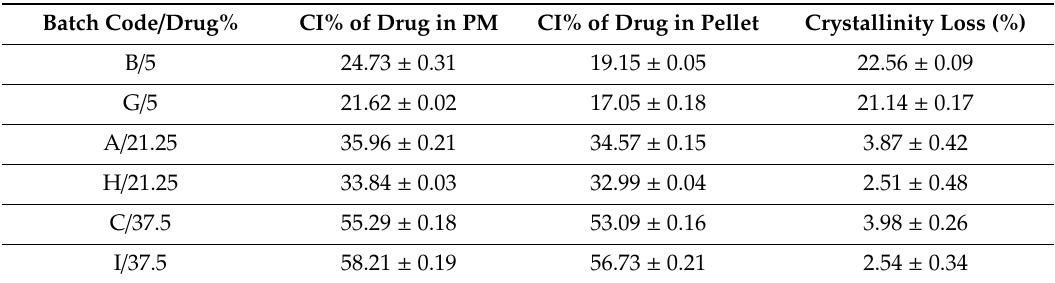
Table 6. Crystallinity index (CI%) of the drug in the experimental pellet batches and the corresponding physical mixtures (PM). (Intensity of the drug at 25.8 2 θ degrees 2132.55 a.u.).